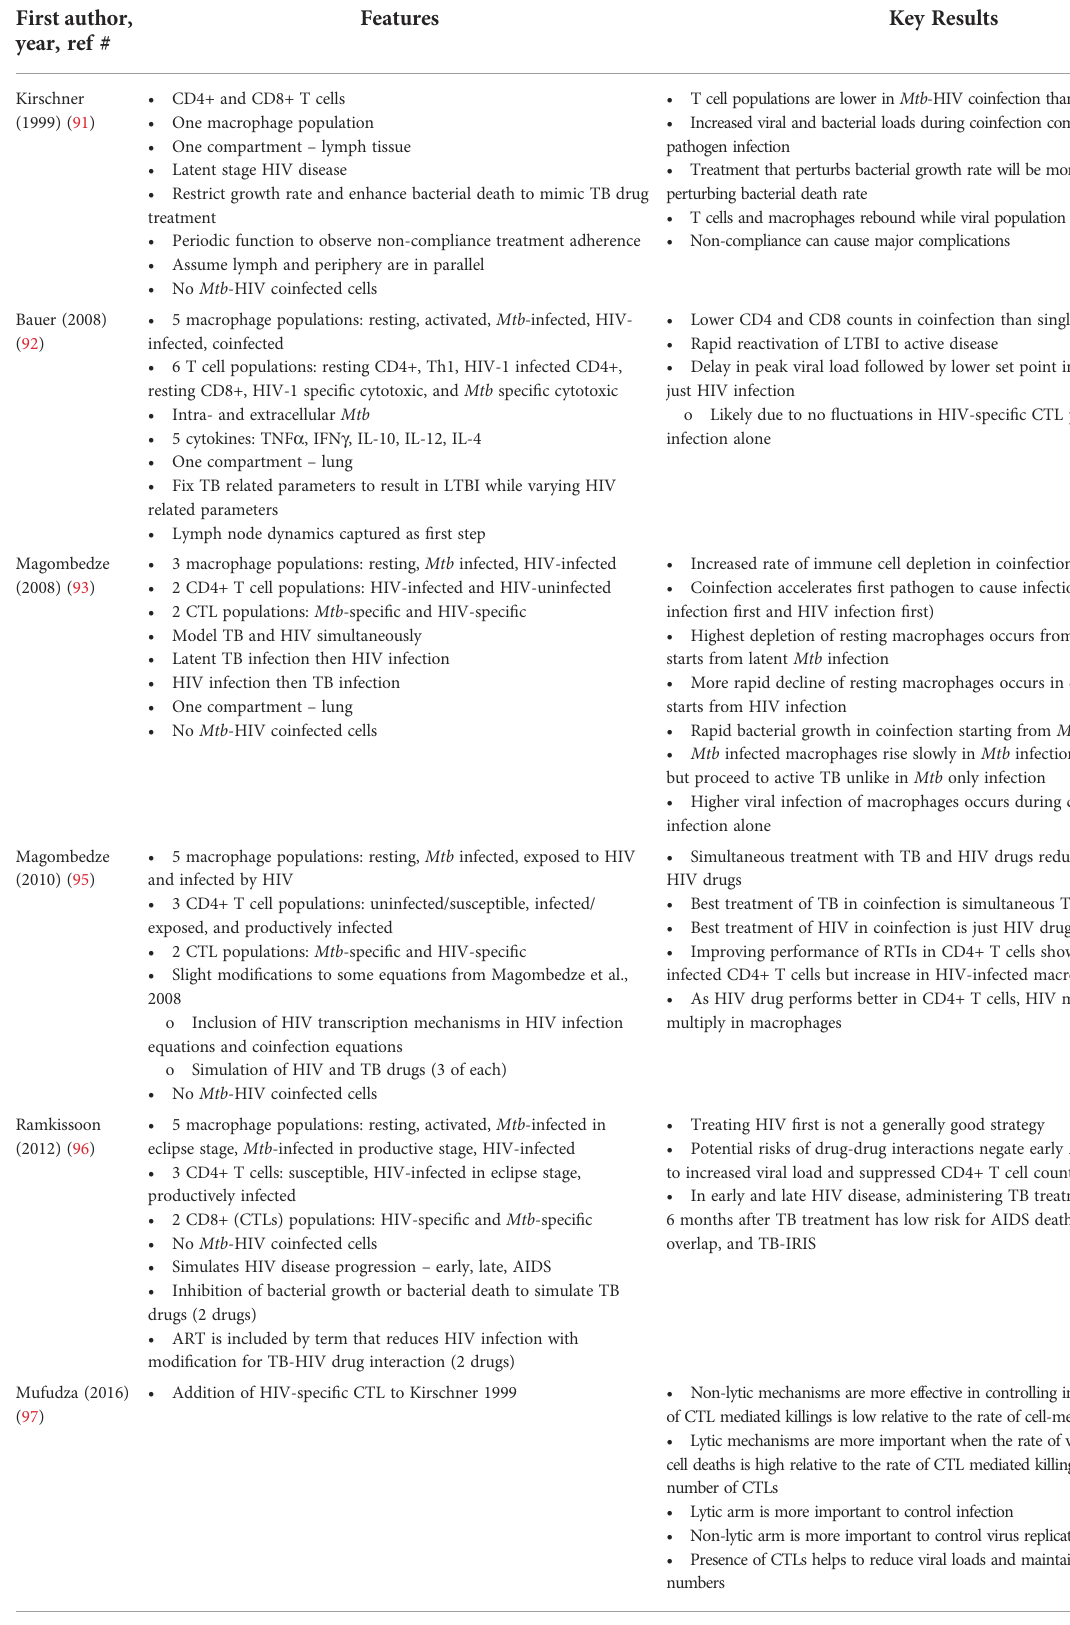
TABLE 1 Computational Models of Mtb -HIV